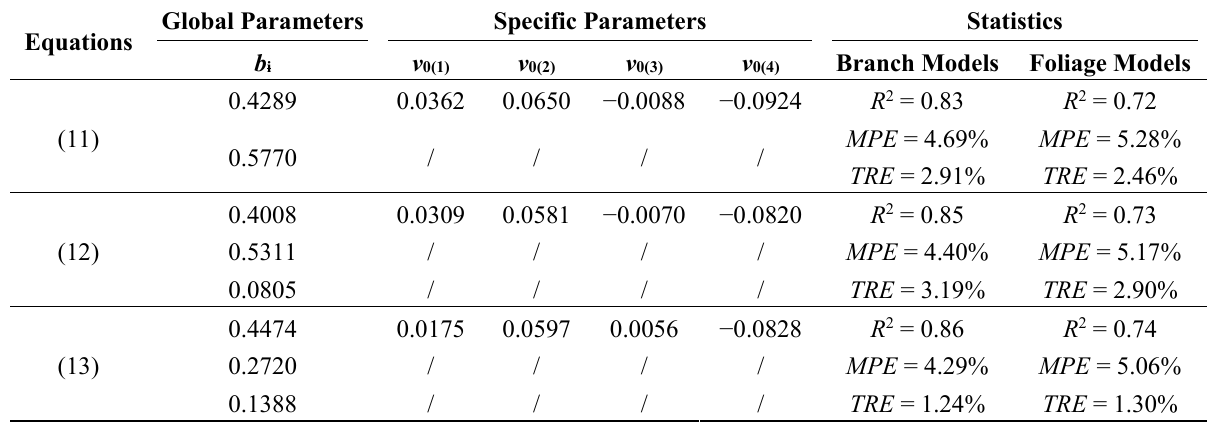
Table 6. The fitting results of simultaneous equations of branch and foliage biomass. Global Equations